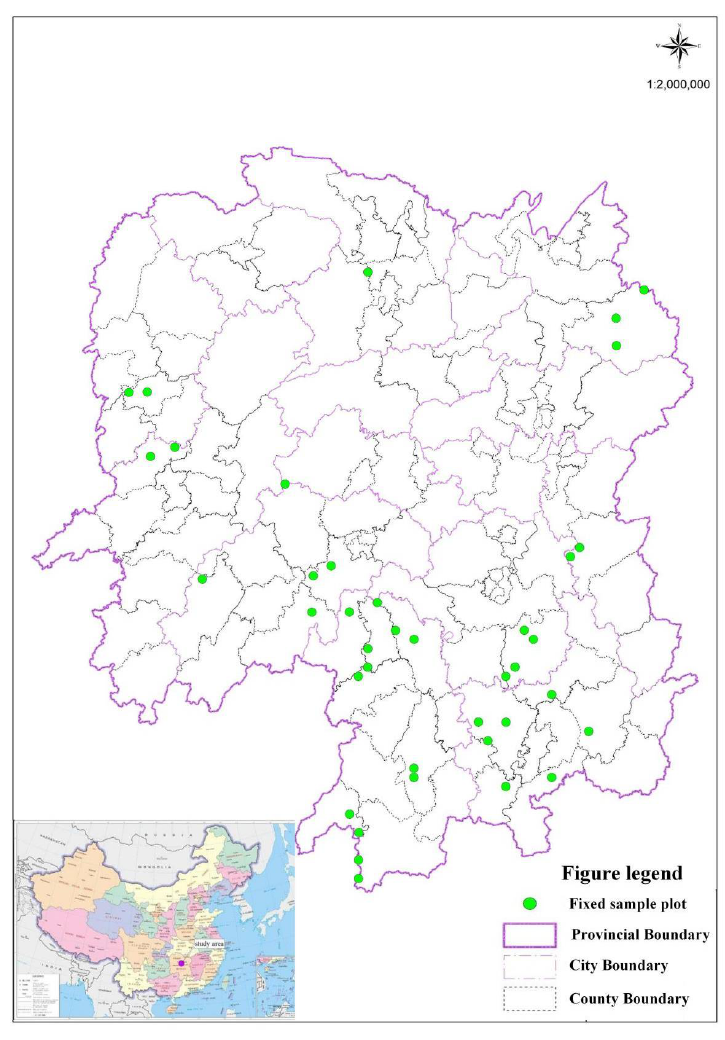
Figure 1. Location of the study area. Green circles represent the plots.